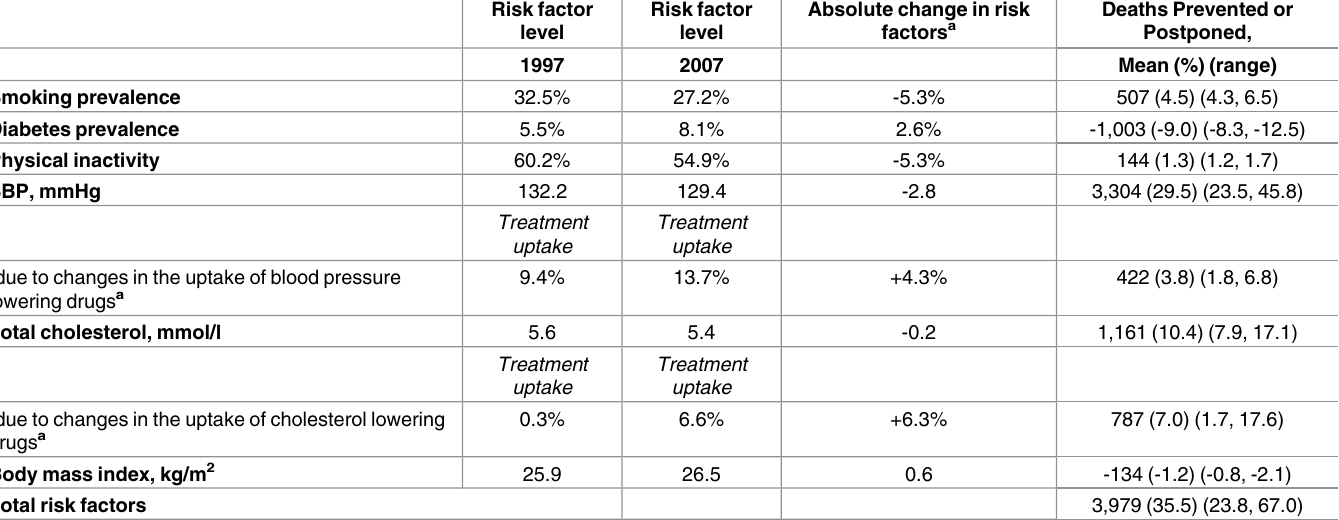
Table 4. Deaths Prevented or Postponed (DPPs) due to changes in risk factors for coronary heart disease including the effect of changes in pri- mary prevention treatments between 1997 and